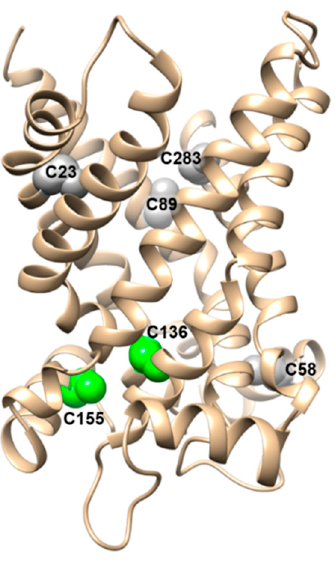
Figure 8. CAC structural model showing the two redox-sensitive cysteines. Lateral view of a ribbon diagram of the carrier in which the cysteine residues are displayed by a sphere representation. Cys-136 and Cys-155 are highlighted in green.